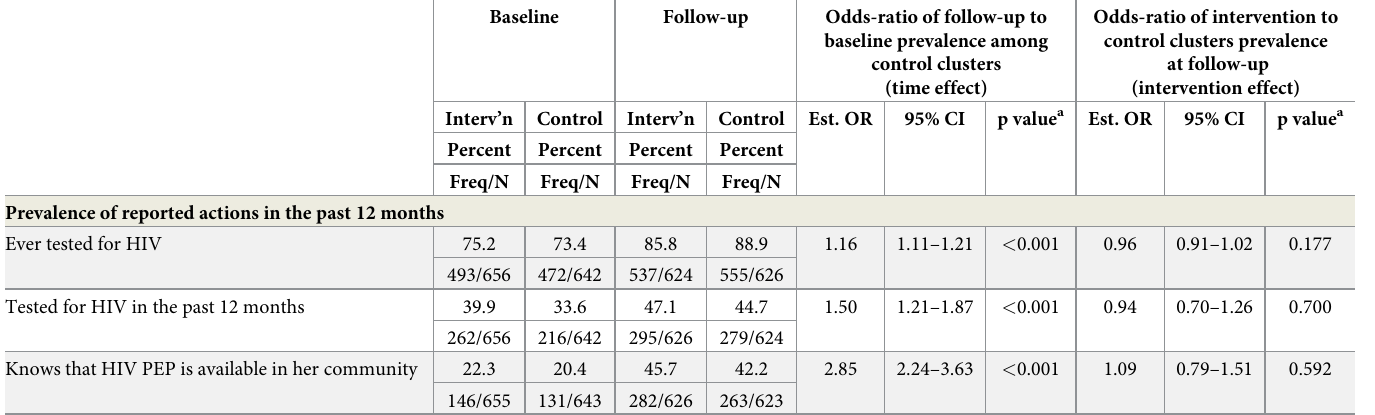
Table 12. HIV testing and knowledge of PEP